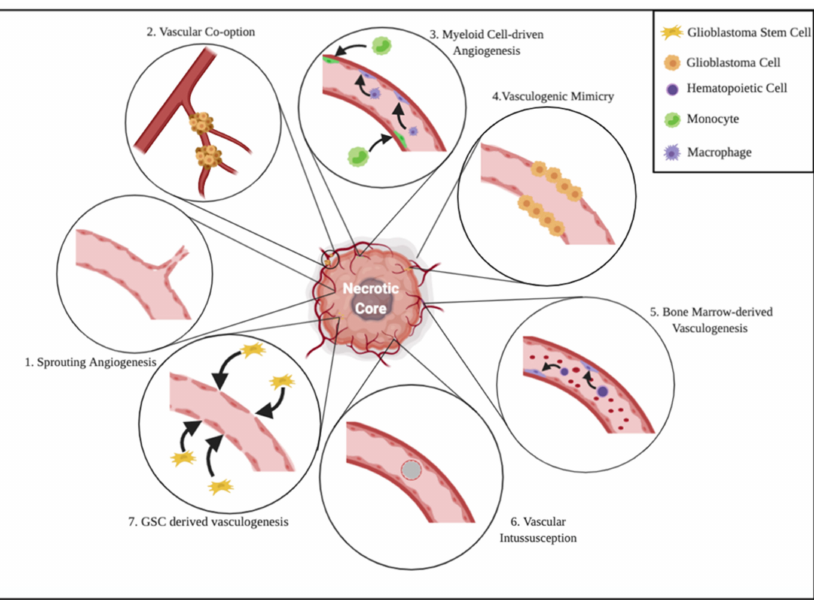
Figure 1. Cell biology of glioblastoma angiogenesis. As previously stated in the text, the relevance of some of these mechanisms in this kind of tumor remains uncertain. 1. Sprouting